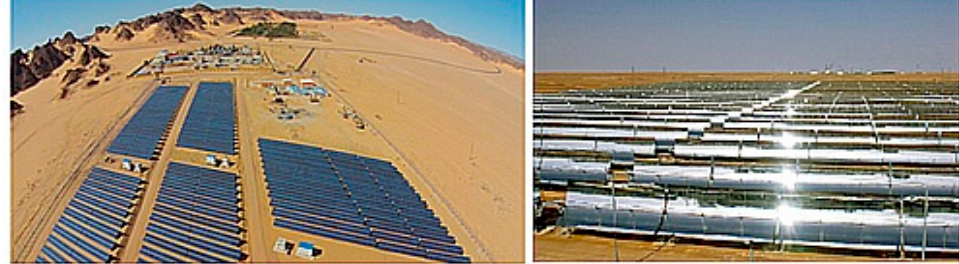
Figure 12. Solar projects in the Algerian Sahara.